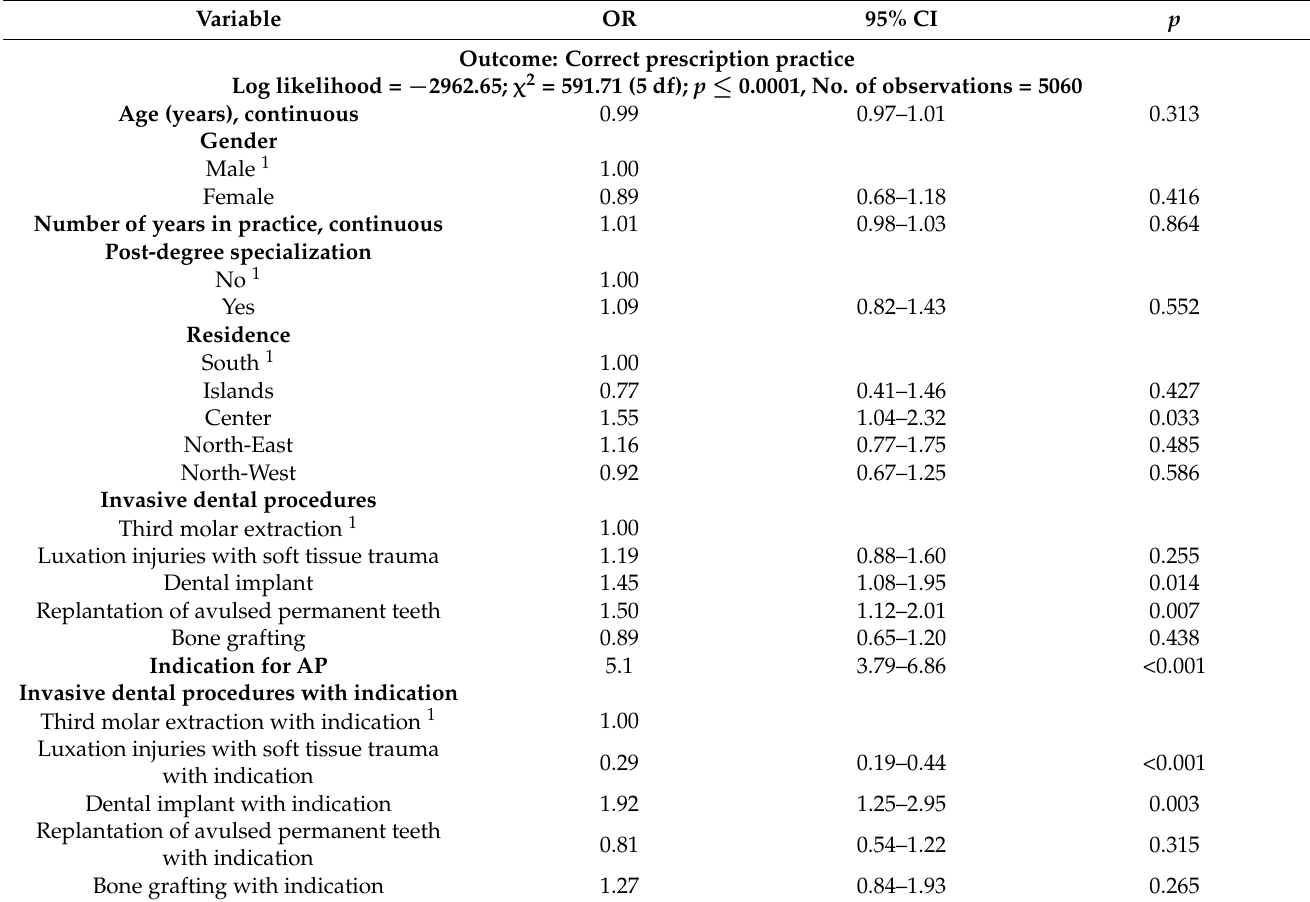
Table 3. Multilevel mixed-effect logistic regression model results exploring determinants of correct prescription practices.